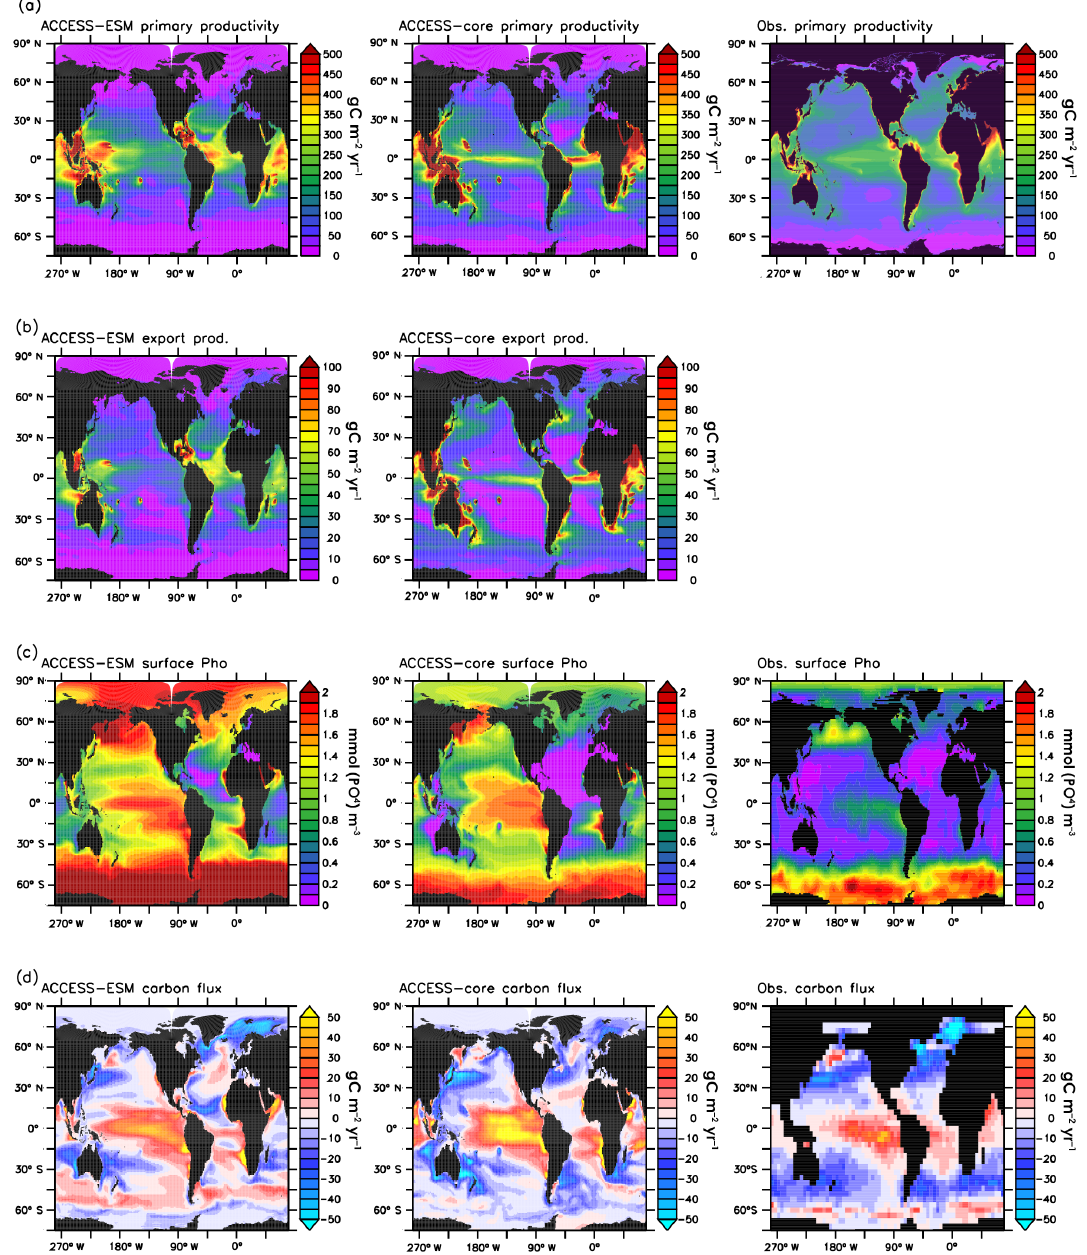
Figure 10. Comparison of the ACCESS-ESM1 simulation (left column) for the years 901–1000 with an ocean-only simulation (middle col- umn) and with the observations (right column) for (a) primary productivity in gCm − 2 yr − 1 , (b) export production at 100 m in gCm − 2 yr − 1 , (c) surface phosphate in mmolPm − 3 and (d) mean sea–air flux of CO 2 in gCm − 2 yr − 1 . Observed primary productivity is based on the Eppley-VGPM algorithm. The surface phosphate observations come from the World Ocean Atlas climatology (WOA2005; Garcia et al., 2006a). The annual sea–air CO 2 fluxes are from Takahashi et al.